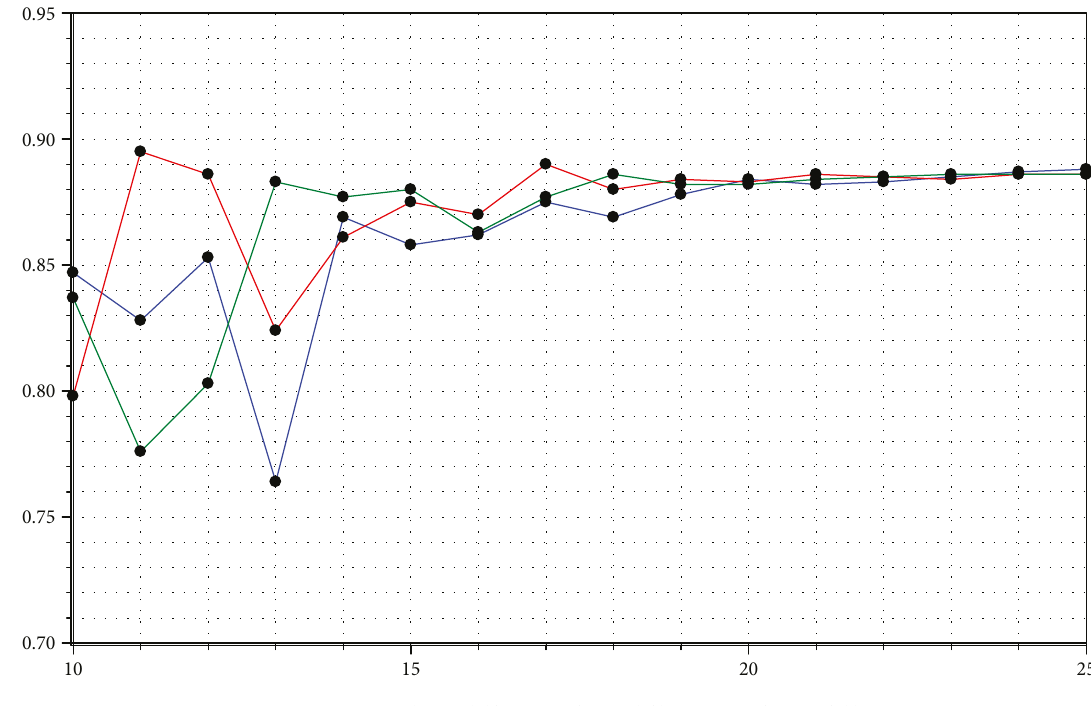
n . Red: α k , S 4,2